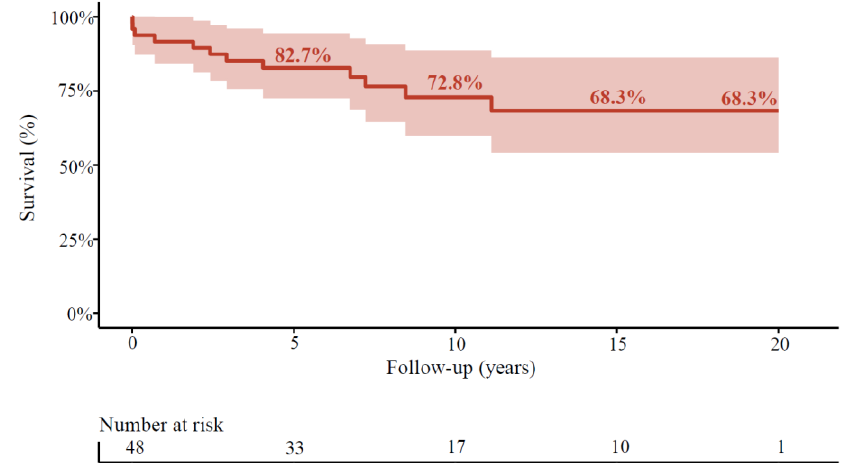
Figure 1. Long-term survival after surgical aortic valve replacement (SAVR) with aortic surgery. Survival in overall cohort. The shaded area represents the 95% confidence interval.